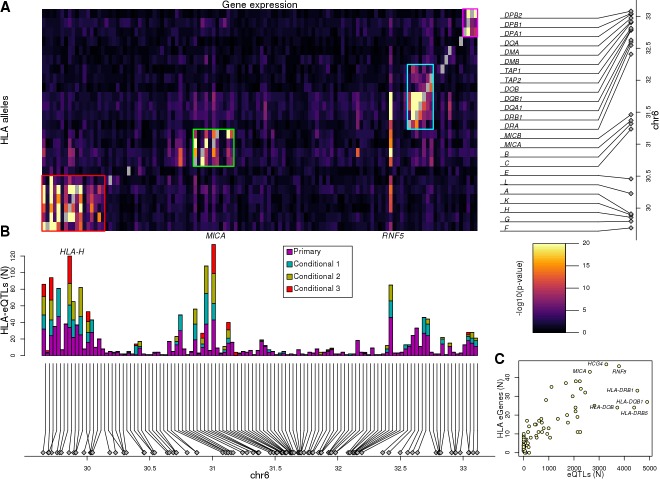
Associations between HLA types and gene expression levels in the MHC region.(A) Heatmap showing the associations between HLA types at 8-digit resolution (Y axis) and the expression of 114 genes in the MHC region (X axis). For eGenes associated with multiple HLA-type eQTLs, only the most significant p-value is shown. Self-associations between the expression of each HLA gene and its HLA types were not considered (grey squares). Four different groups of genes with shared HLA-eQTLs are outlined in different colors. (B) Barplot showing for each of the 114 genes in the heatmap in (A), the number of primary and conditional associations (adjusted based on the lead eQTL, the top two independent eQTLs, or the top three independent eQTLs) between HLA types and gene expression levels. ‘Conditional 1’ refers to HLA-eQTLs conditional on the lead primary SNP eQTL, ‘Conditional 2’ refers to HLA-eQTLs conditional on the lead primary and lead conditional 1 eQTLs and ‘Conditional 3’ refers to HLA-eQTLs conditional on the lead primary, conditional 1 and conditional 2 eQTLs. (C) Scatterplot showing the number of primary eQTLs (X axis) and the number of primary HLA-type eQTLs (Y axis) for the 52 genes that had both eQTLs and HLA-type eQTLs.